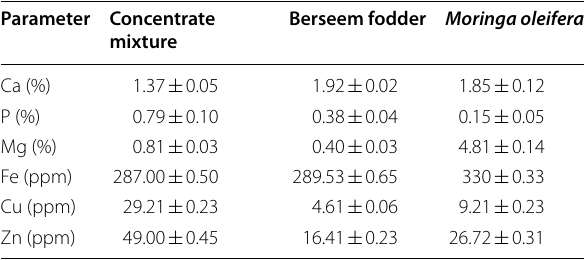
Table 2 Proximate mineral composition of berseem fodder, concentrate and Moringa leaves Parameter Concentrate mixture